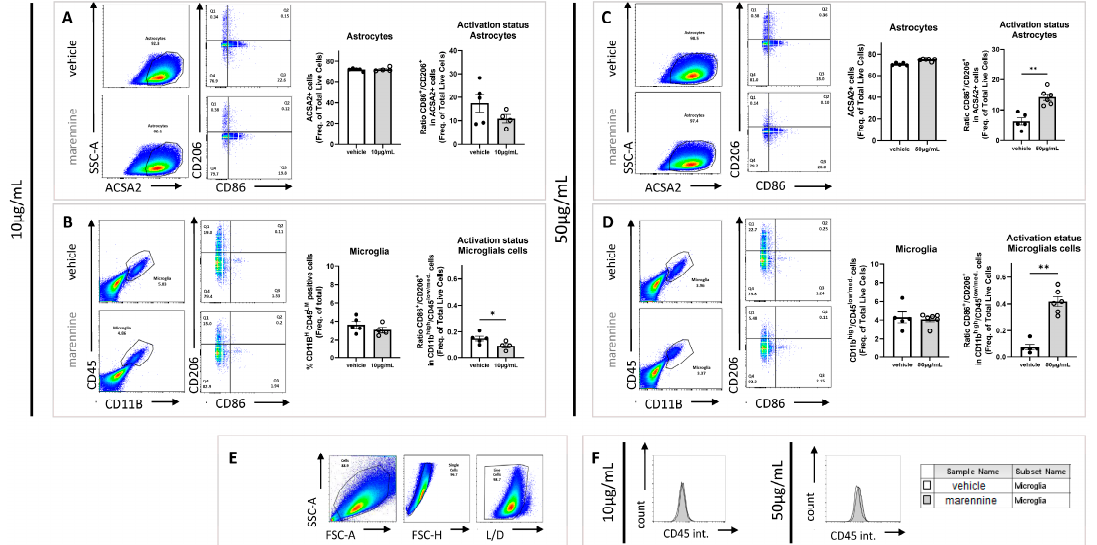
Figure 3. Effects of 10 and 50 µ g/mL of marennine on astrocytes and microglial cells after 24 h of exposure. ( A ) Astrocytes were gated as ACSA2 positive; activation status was determined through CD86 and CD206 staining after exposure to 10 µ g/mL marennine. ( B ) Microglial cells were gated as CD11b high and CD45 low/medium; activation status was determined through CD86 and CD206 staining after exposure to 10 µ g/mL marennine. ( C ) Astrocytes were gated as ACSA2 positive; activation status was determined through CD86 and CD206 staining after marennine exposure at 50 μ g/mL. ( D ) Microglial cells were gated as CD11b high and CD45 low/medium; activation status was determined through CD86 and CD206 staining after marennine at 50 µ g/mL. ( E ) Cell populations and activation status were determined by flow cytometry. A gate was first created on non-debris populations, excluding very low SSC/FSC events; cells are then gated on single cells and selected by Live/Dead staining. ( F ) Quantification of CD45 intensity after a marennine of 10 μ g/mL (left) and 50 μ g/mL (right). For 24 h, at 10 μ g/mL vehicle n = 5, marennine n = 4. At 50 μ g/mL vehicle n = 5, marennine n = 6. Values represent mean ± SEM. Significant differences from control are indicated as follows: * p < 0.05; ** p < 0.01 using Mann-Whitney test.